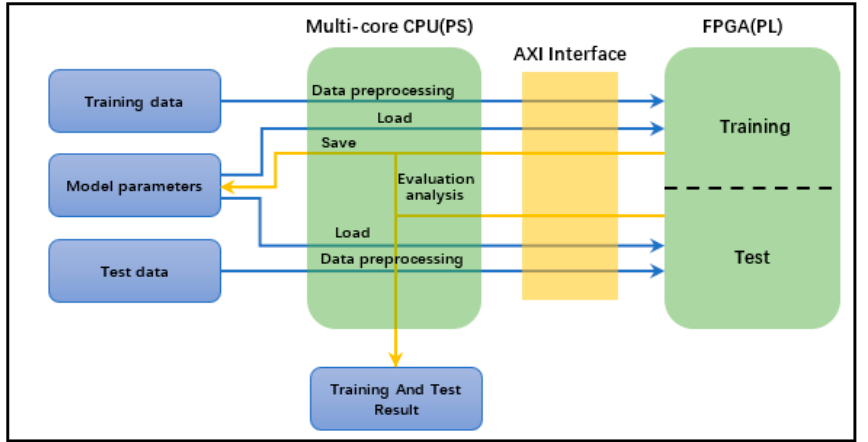
Figure 11. Data flow used to test the training and inference hardware structure of the convolutional neural network. neural